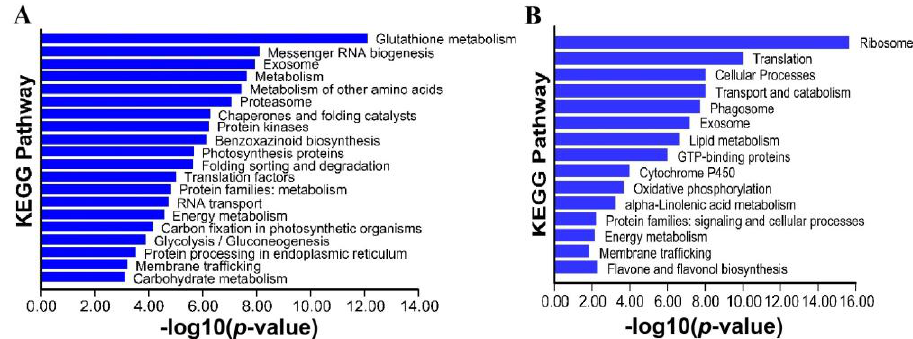
Figure 5. Pathway analyses of ubiquitylome: ( A ) KEGG pathways for up−regulated Kub proteins; and ( B ) KEGG pathways for down−regulated Kub proteins.